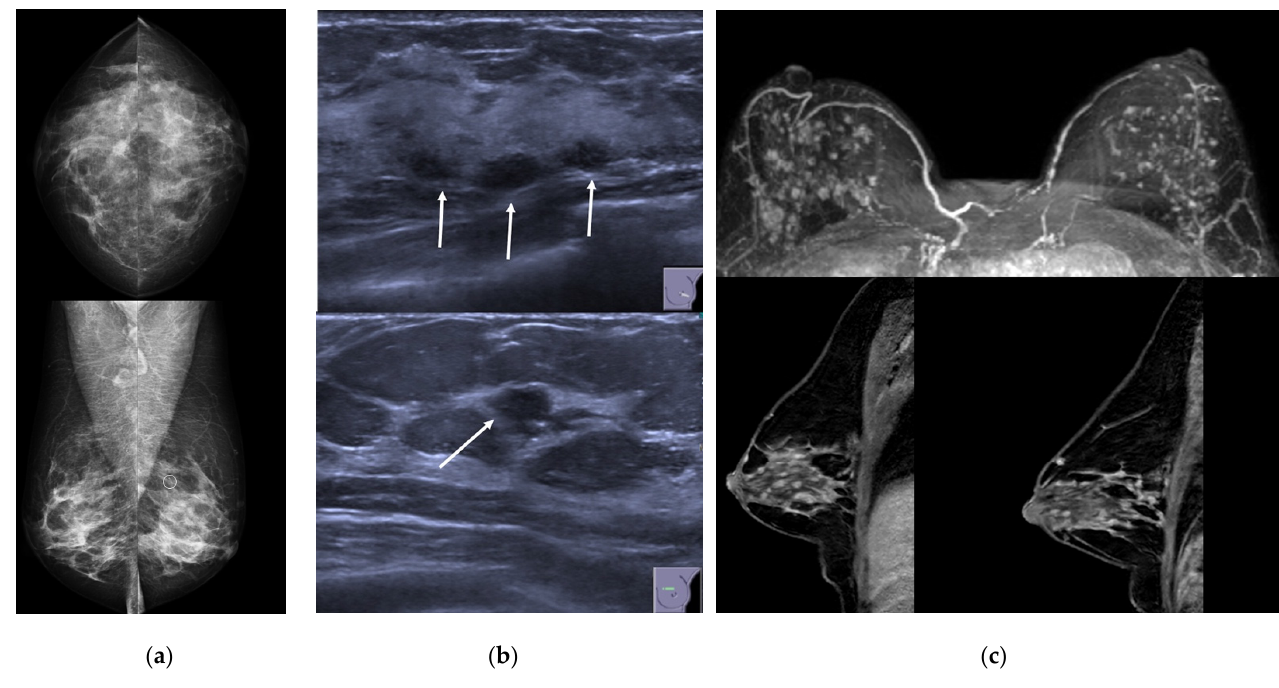
Figure 6. A 43-year-old woman presenting with unilateral bloody nipple discharge. ( a ) Mammography in cranio-caudal and medio-lateral views did not show any mass or asymmetric density, but only a millimetric cluster on calcification in the upper-outer quadrant of the left breast (circle). ( b ) Ultrasound demonstrated multiple small masses with ductal relation (arrows). ( c ) MRI showed multiple enhancing masses associated to ductal contrast enhancement with a “string of pearls” appearance.